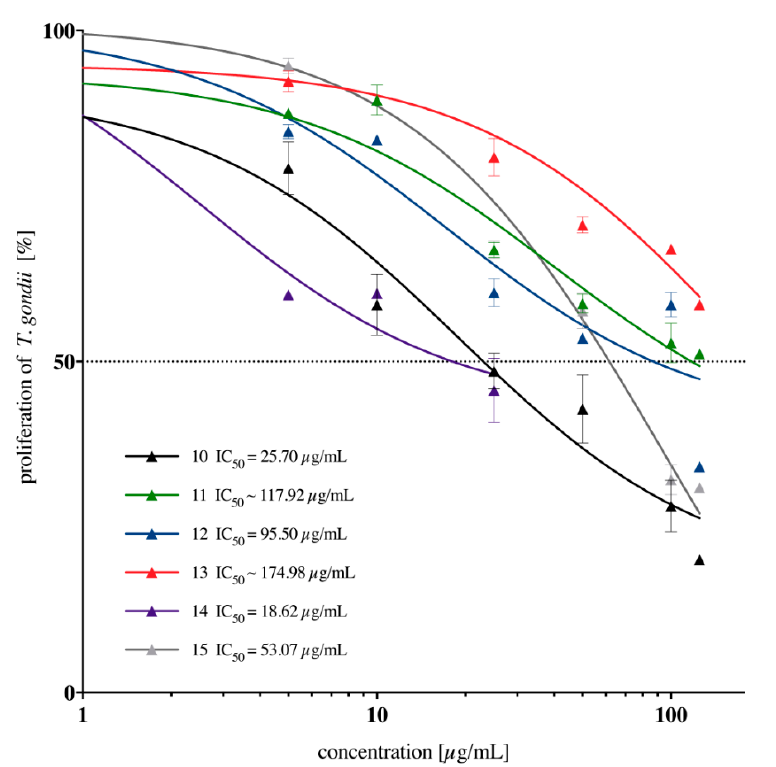
Figure 3. Dose response curves and IC 50 values [µg/mL] of compounds 10 – 15 on T. gondii proliferation.